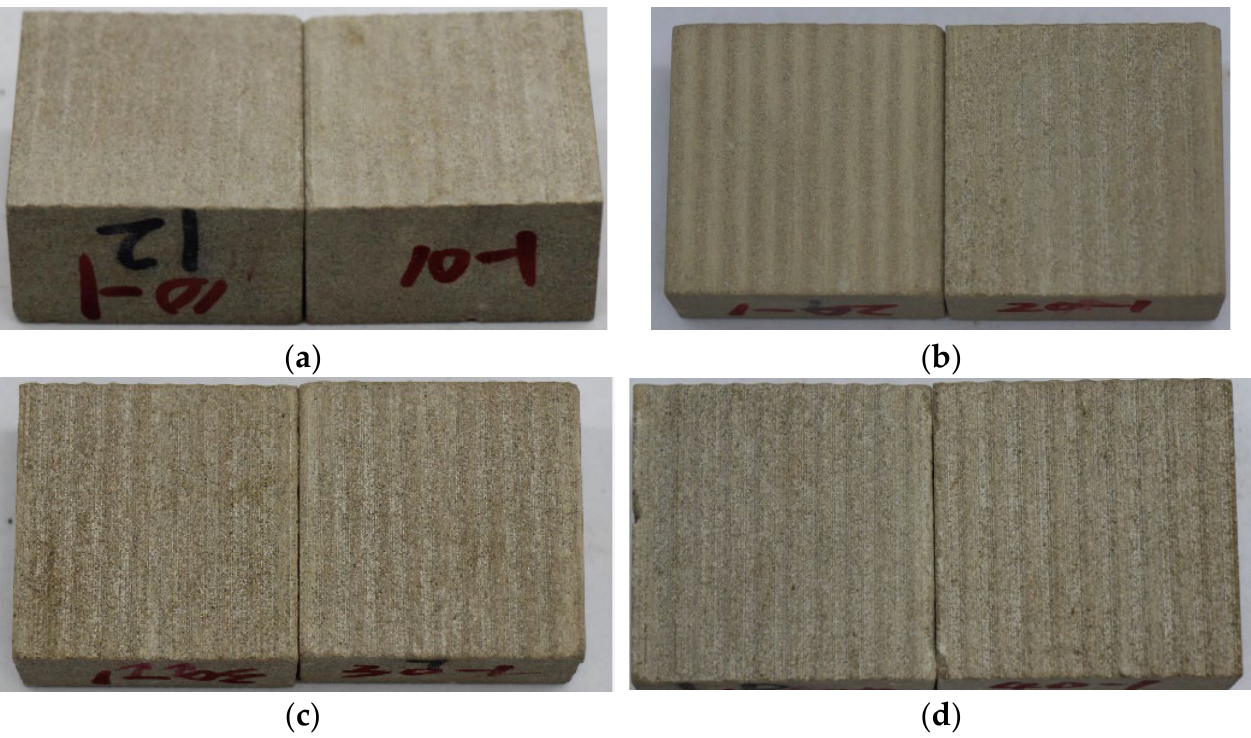
Figure 2. Rock sample surfaces with different undulating angles. ( a ) Undulating angle of 10°; ( b ) Undulating angle of 20°; ( c ) Undulating angle of 30°; ( d ) Undulating angle of 40°.